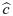
A box plot representation of the dynamic coefficients for joint response to duty cycles of 35% to 65% under 138 kPa (20 psi).The red line is the median, the blue box is the 25th and 75th percentile, the black lines are the bounds of the non-outlying data, and the red circles are the outliers. The 25th and 75th percentiles of a^,b^,c^ are (0.4123,0.3240) rad/s2, (0.9859,1.7316) rad/s and (1.2577,1.637) rad/PWM. and the median of the a^,b^,c^ is 0.2006 rad/s2, 1.2319 rad/s and 1.6022 rad/PWM.